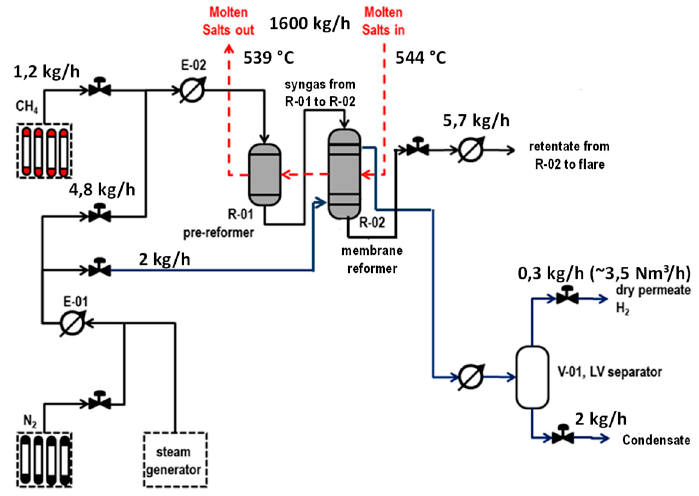
Figure 1. Solar energy-assisted membrane pilot plant process scheme.